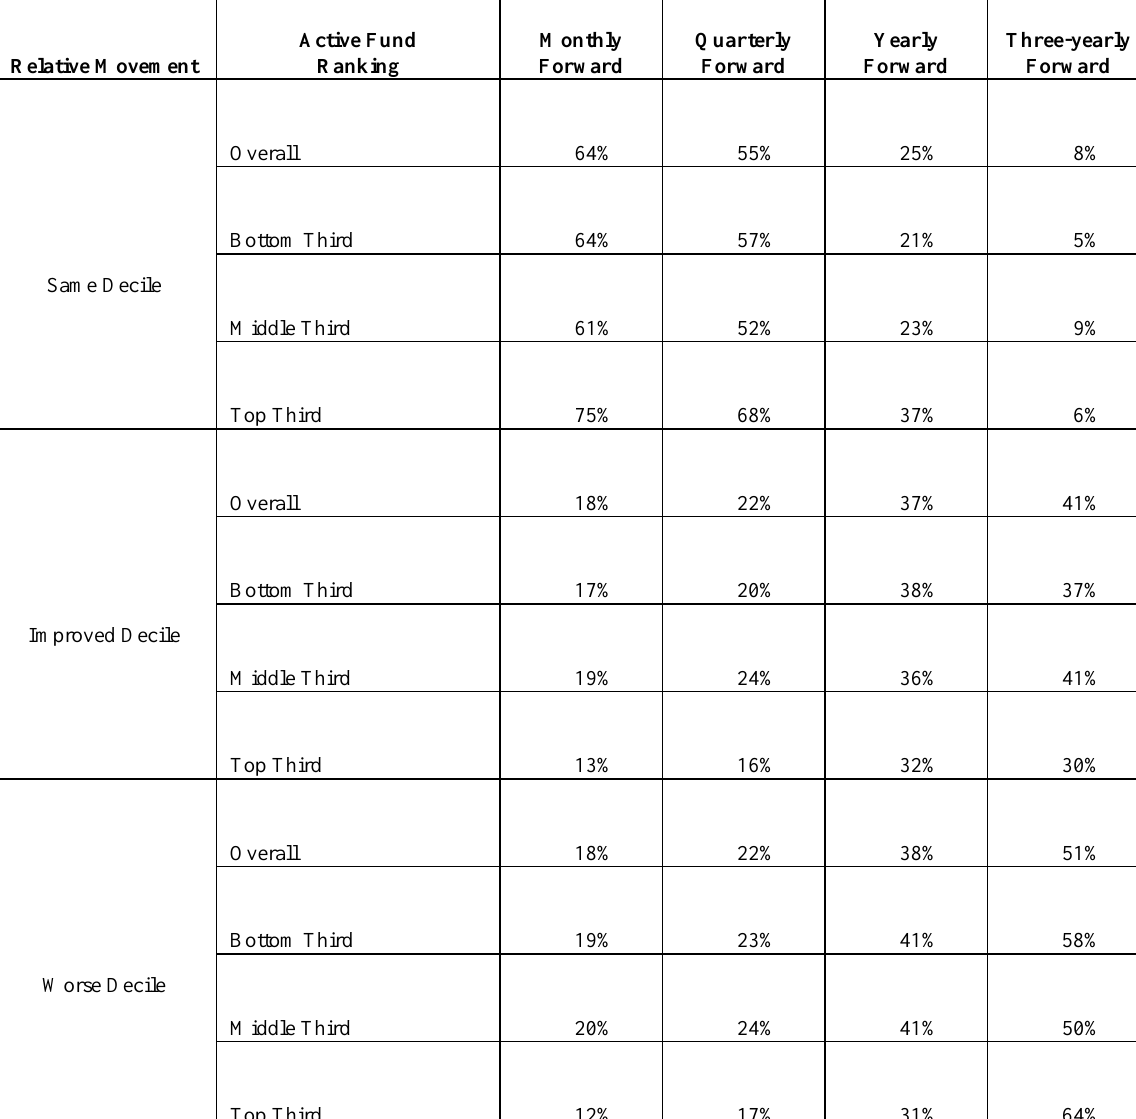
Table 5: Relative movement of actively managed funds between deciles over different forward-looking periods